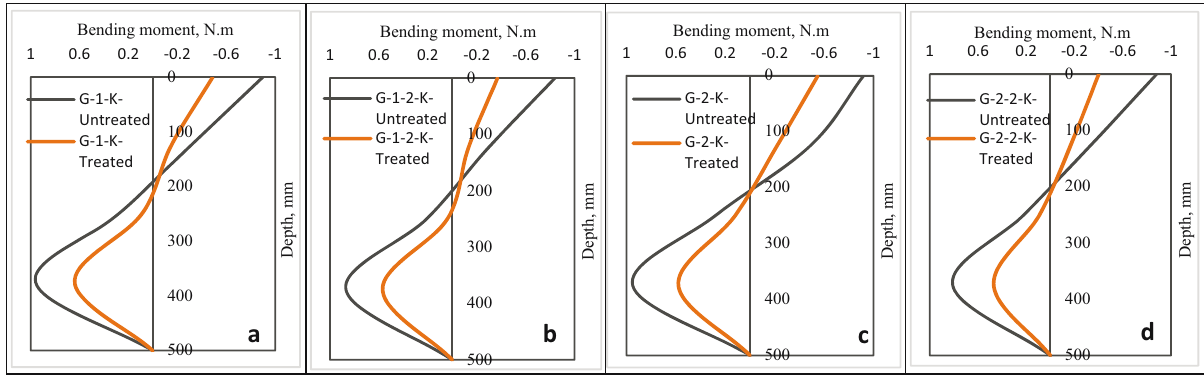
Figure 9: Bending moment of the pile group in treated and untreated soil with nano - SiO 2 – P2 at ( a ) 50% axial load, ( b ) 50% axial load and lateral load, ( c ) 100% axial load, and ( d ) 100% axial load and 100% lateral load.